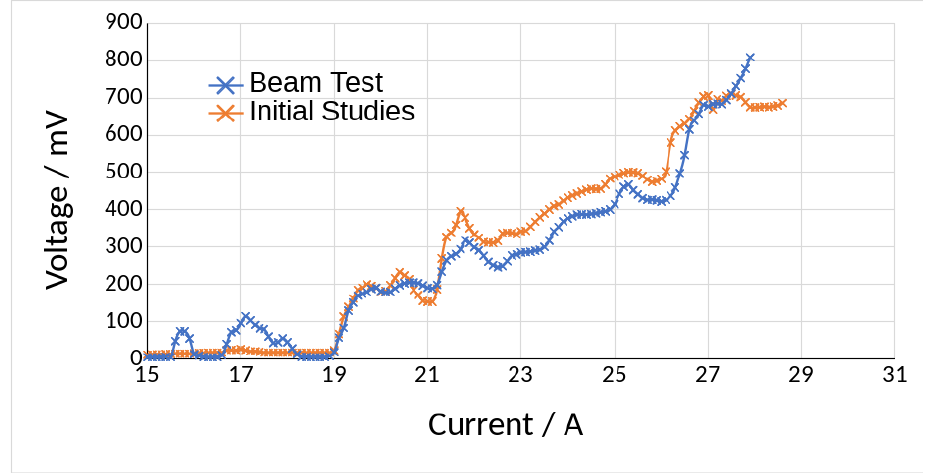
Figure 8. Voltage-current characteristic of the Gabor lens measured with the lens on the beam line (blue crosses) compared to measurements in the laboratory at Imperial (orange crosses). During the beam test the gas pressure in the lens was 10% higher than the pressure at which the lens operated in the